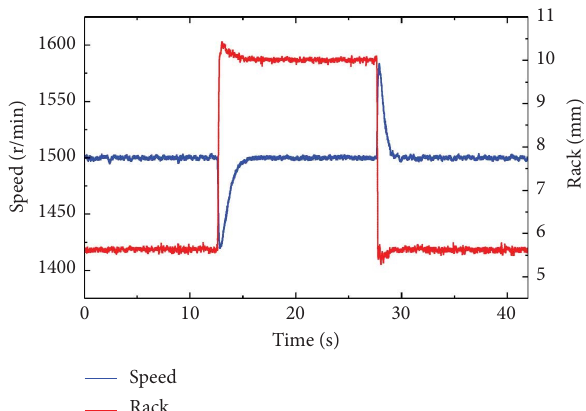
Figure 20: Experimental results of load sudden change for the improved PID algorithm.